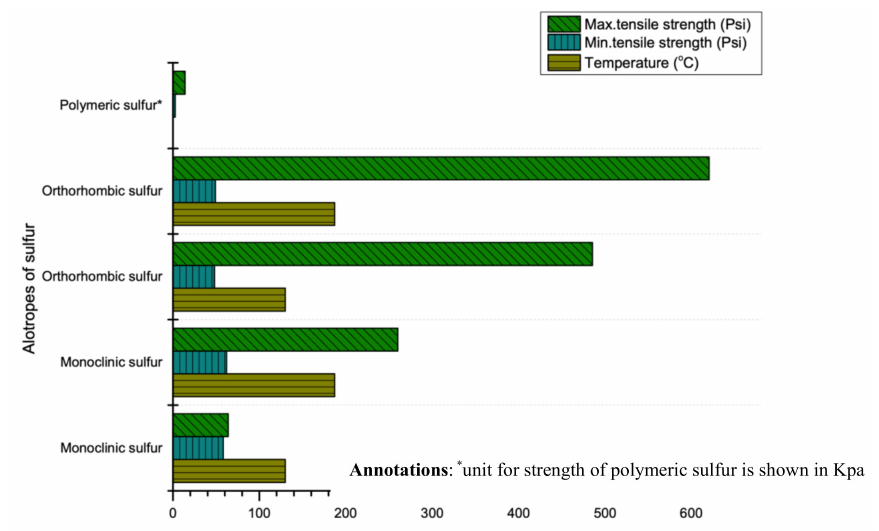
Figure 8. Tensile strength range of sulfur at various temperatures (data extracted from Reference